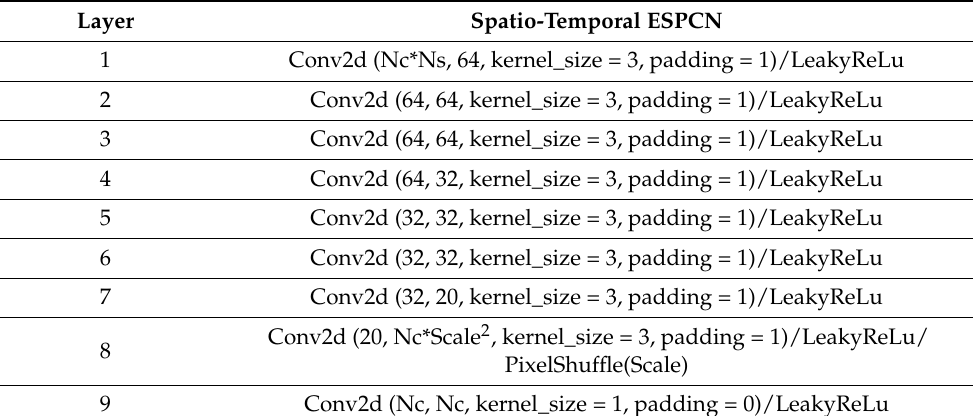
Table 5. Spatio-Temporal ESPCN (9 Layer Early Fusion Network). Nc means the number of input image channels, 1 in this model and Ns is the number of sequential frames used for network inputs, 2 in this